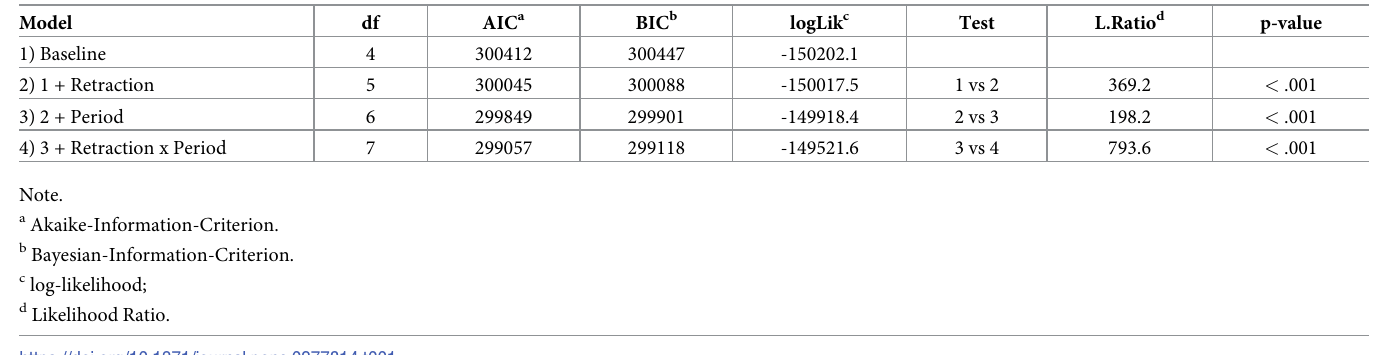
Table 1. Results for mixed linear effects